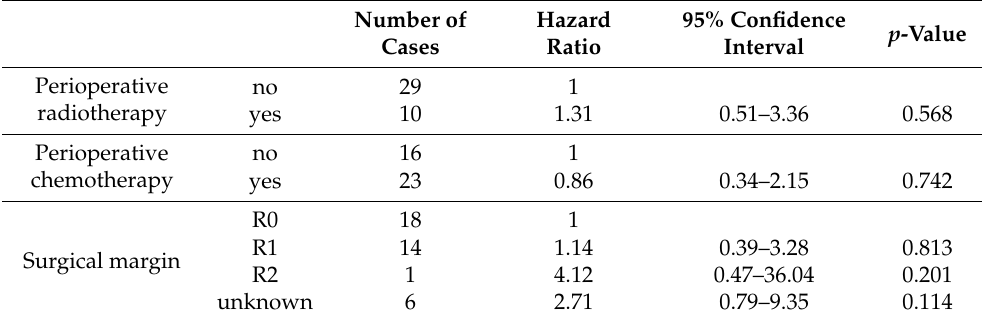
Table 4. Hazard ratios for death with 95% confidence intervals and p -values calculated from a univariate Cox proportional hazards model for patients who underwent curative